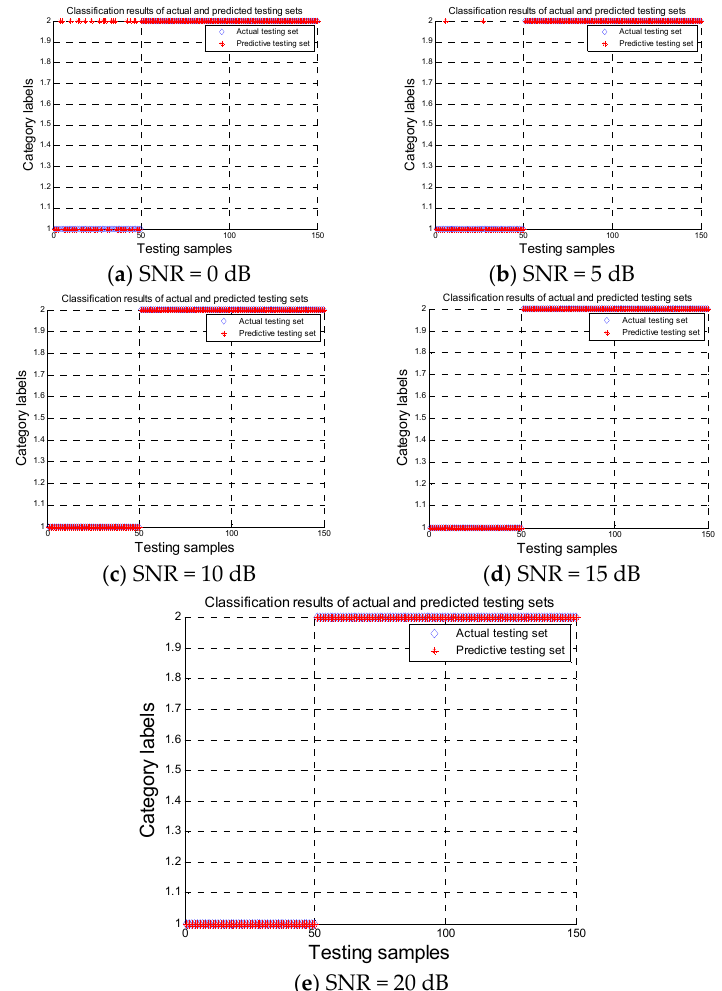
Figure 8. Sorting results based on support vector machine (SVM) classifier in different SNRs. The relationship between the sorting accuracy and SNR is shown in Figure 9.